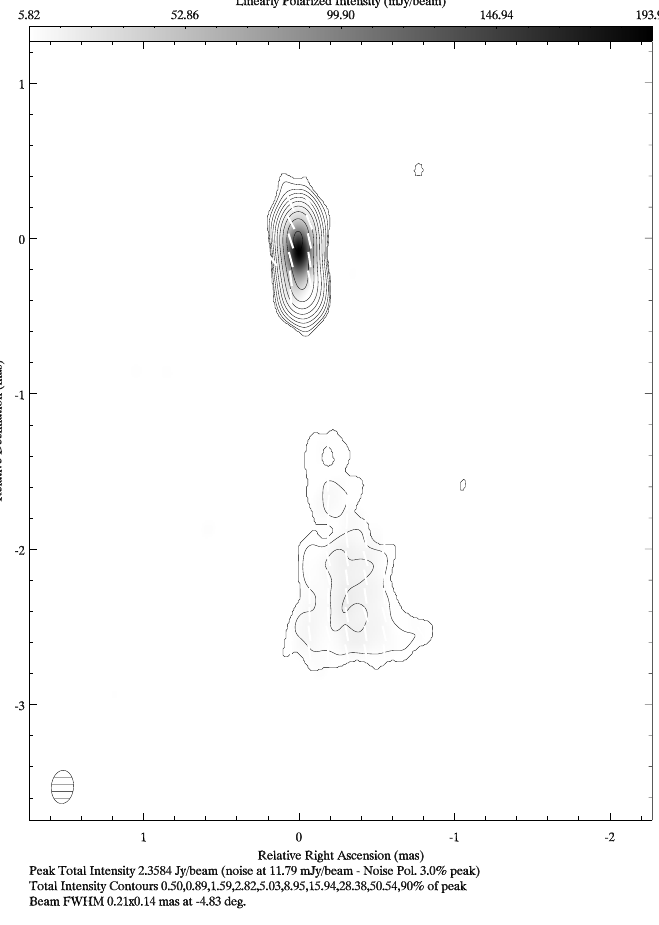
Figure 3. Same as Figure 1 at 43 GHz.